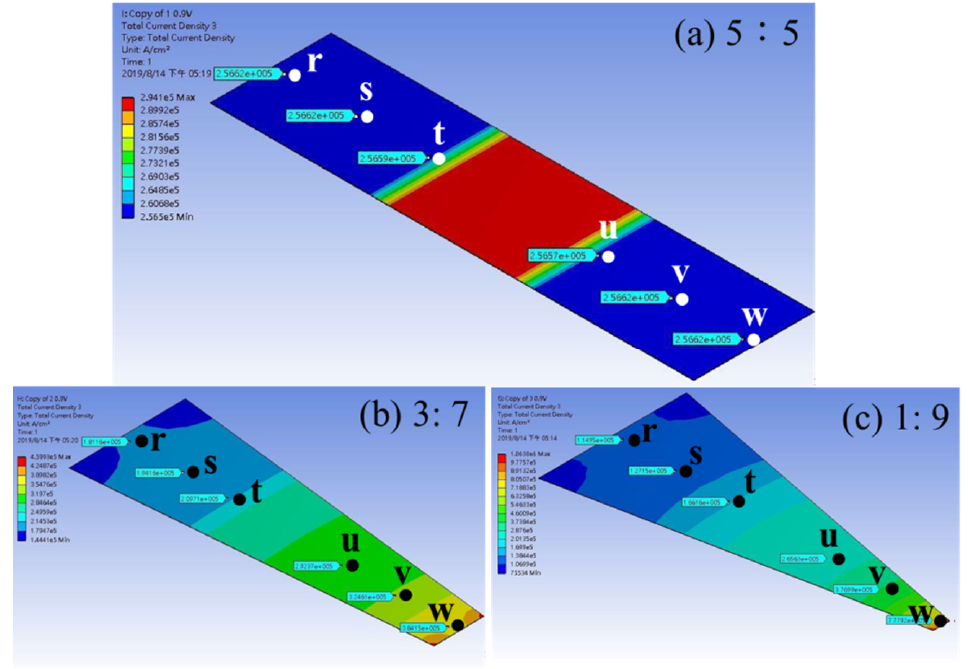
Figure 6. The current density distribution of the Cu–Sn thin film samples after being subjected to a fixed current of 0.8 A, for the ( a ) 5:5 sample; ( b ) 3:7 sample; and ( c ) 1:9 sample. Table 2. The changes in the current density of the samples at different points.